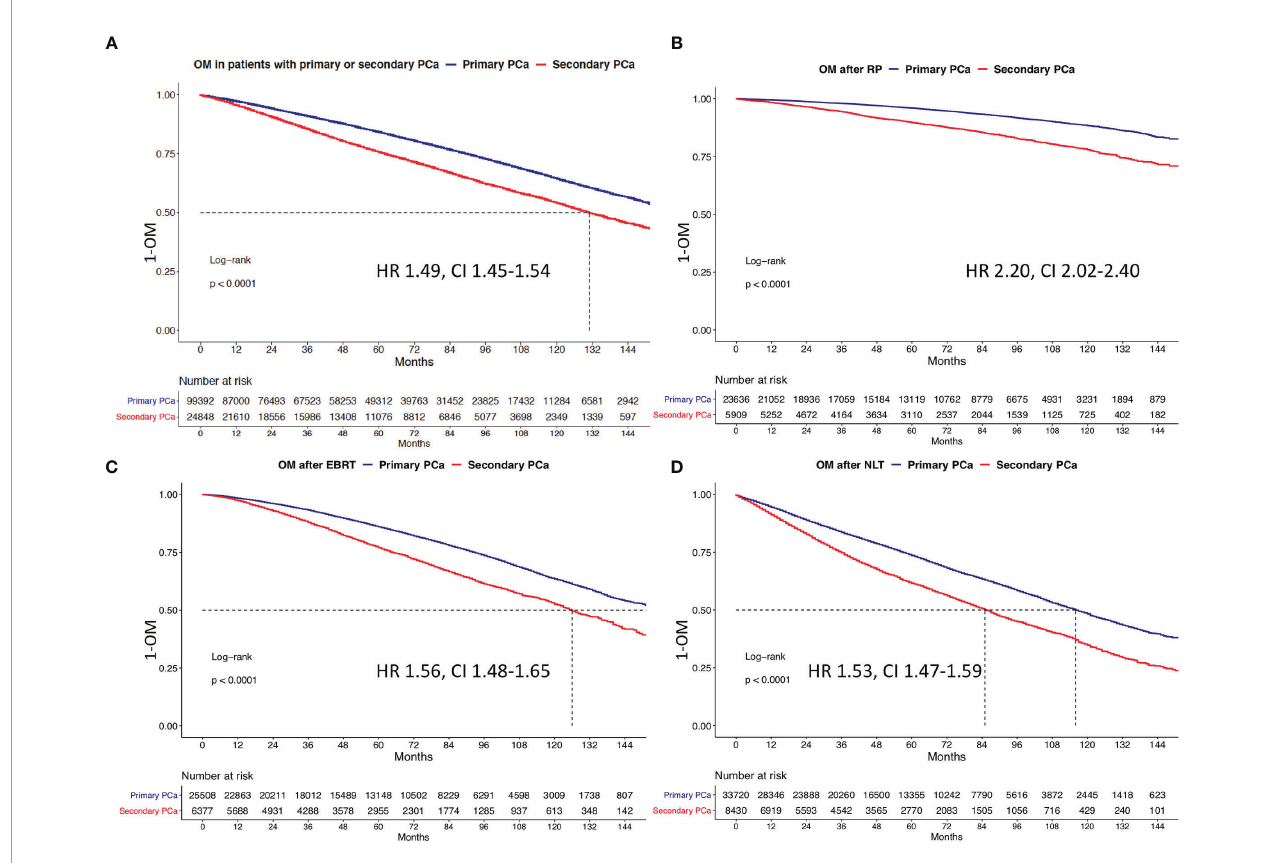
FIGURE 2 | Kaplan-Meier plots depicting overall mortality (OM) for primary and secondary prostate cancer for (A) the overall cohort, (B) patients treated with radical prostatectomy (RP), (C) patients treated with external beam radiation therapy (EBRT), and (D) no local treatment (NLT). HR, hazard ratio; CI, con fi dence